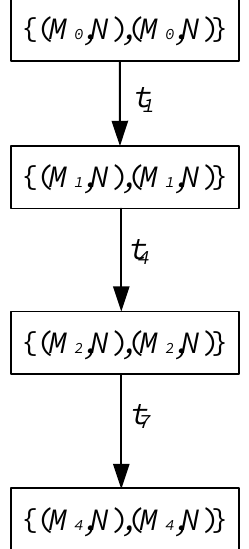
Figure 12. The basis verifier G V